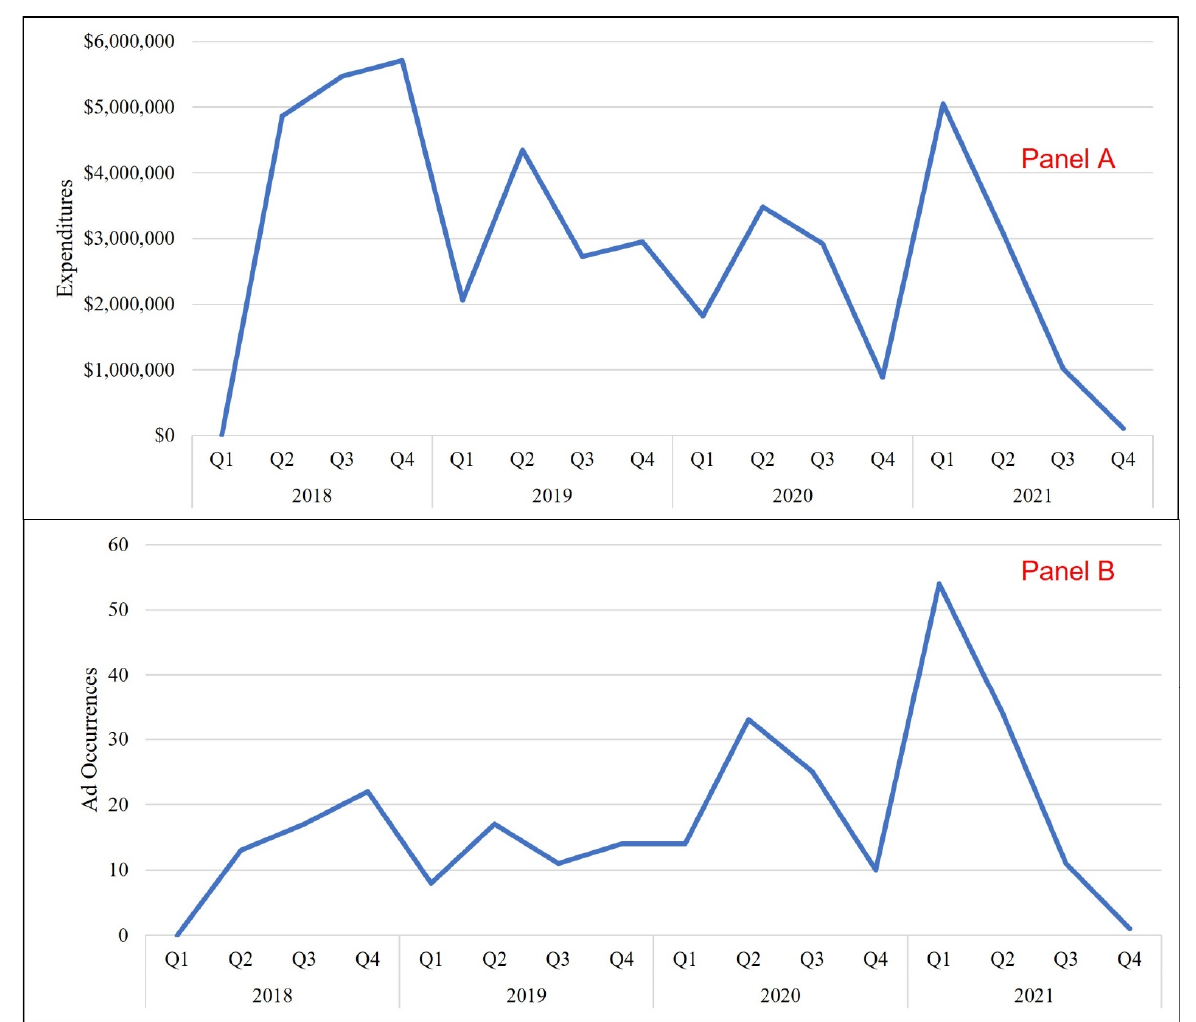
Figure 1. Print Magazine Advertising Expenditures (Panel A) and Occurrences (Panel B) for Black & Mild Cigars, 2018–2021.